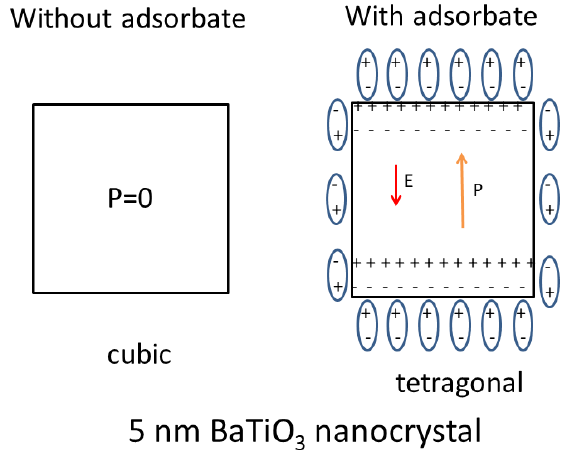
Figure 6. Size effect of a 5 nm BaTiO 3 nanocrystal with and without adsorbate-induced charge screening. Reprinted with permission from Ref. [131]. Copyright 2013, the American Chemical So- ciety.